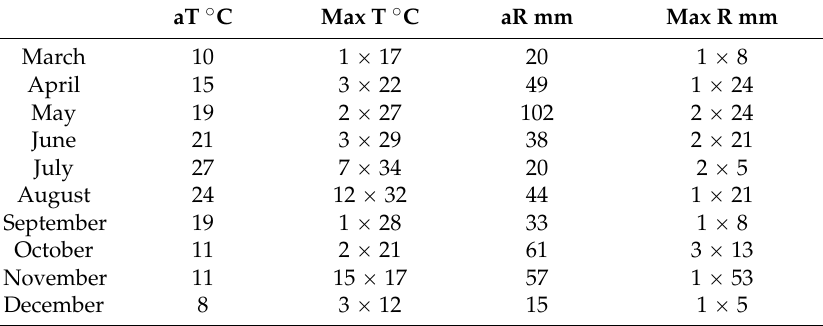
Table 1. Monthly climate data from 2015 indicating average temperatures (aT), max.